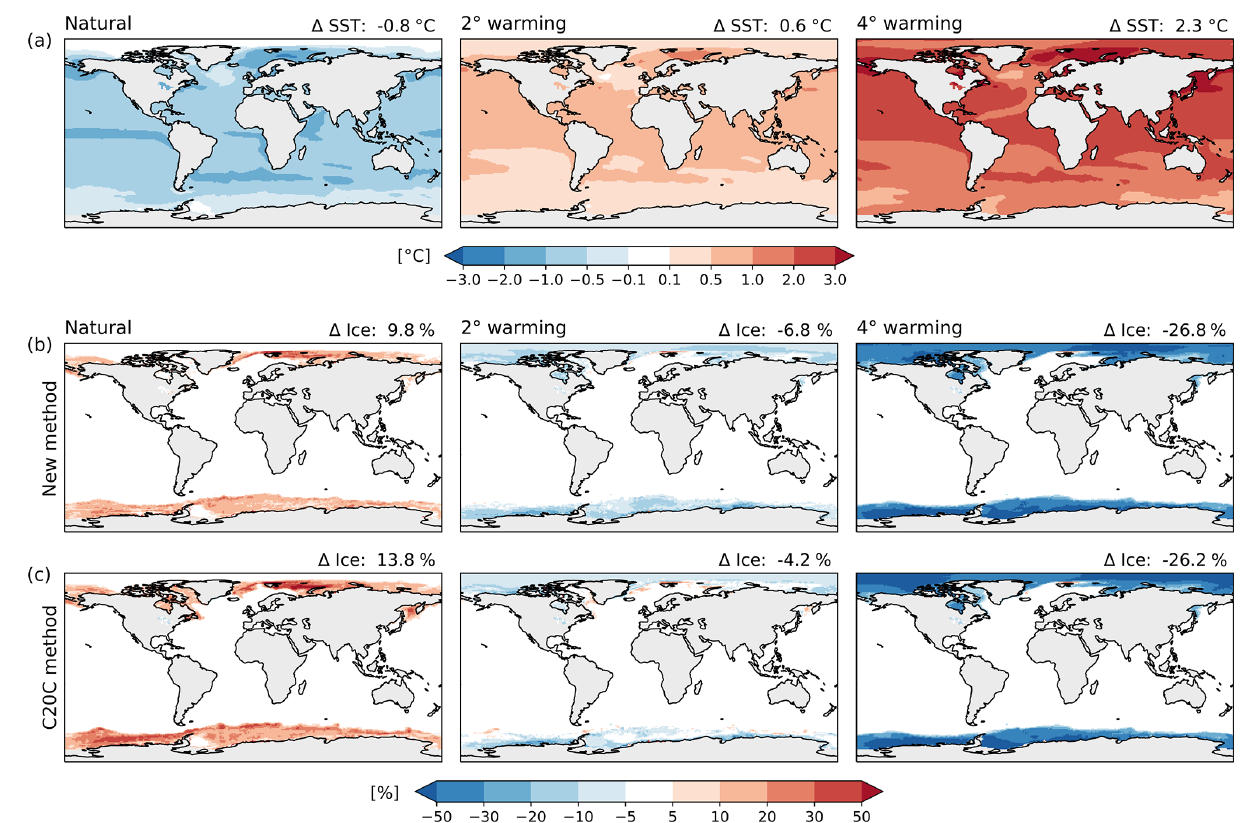
Figure 2. Change in SST and sea ice coverage with respect to historical conditions from NOAA OIv2 for the natural (left), warming20 (middle) and warming40 (right) scenarios. (a) Average delta SST for 2018 under the three climate scenarios. (b) Average sea ice coverage change for 2018 under the three climate scenarios using the sea ice estimation method developed in this study. (c) Same as in the (b) but using the C20C method to compute the